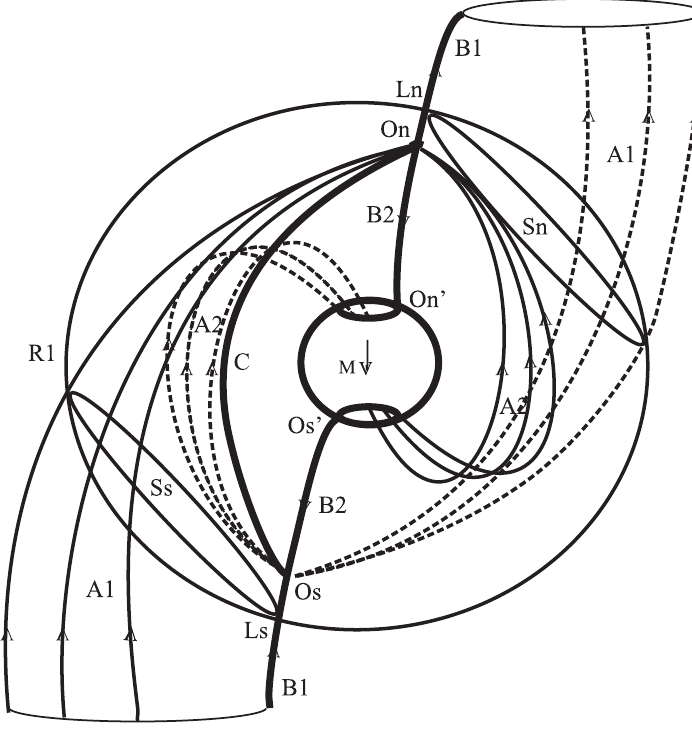
Fig. 1. Magnetospheric magnetic field structure for northward IMF. Sphere of the radius R 1 schematically marks the magnetopause. A 1 and A 2 are the boundaries between the field lines of different topological types. B 1 and B 2 are the singular magnetic field lines perpendicular at the neutral points On and Os to the magnetic field line surfaces A 1 OnA 2 and A 1 OsA 2. On 0 and Os 0 are the ionospheric projections of the magnetic field neutral points. C is the separator line. M is the Earth’s dipole. S s and S n are the southern and northern sections of the magnetopause by the open field line tubes. L s and L n are the points of the intersections of S s and S n with the singular magnetic field lines B 1 ,